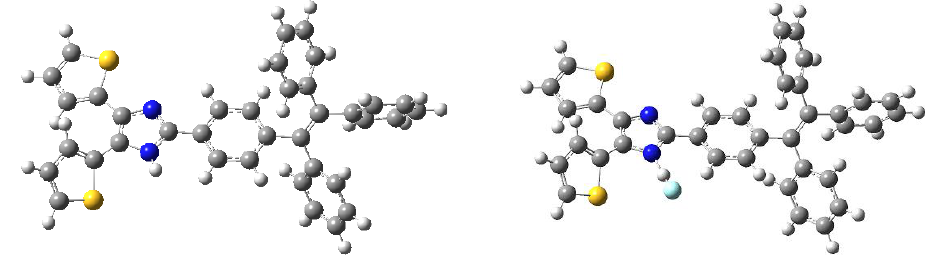
Figure 7. Energy levels diagram of DTITPE and DTITPE.F - calculated by